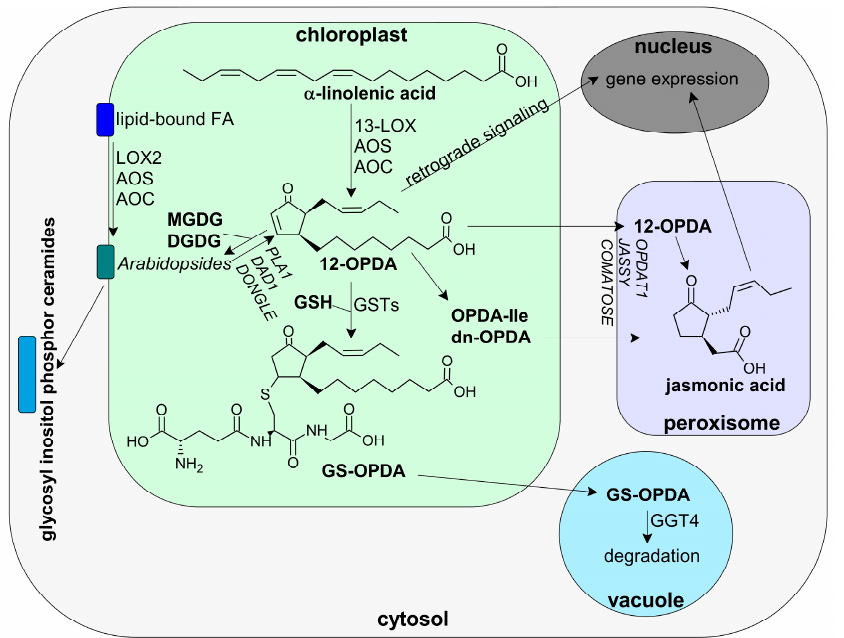
Figure 5. Synthesis and metabolic conversion of 12-OPDA in plant cells. After synthesis from α -LeA by 13-LOX, AOS, and AOC, 12-OPDA can be transported to peroxisomes through the cytosol and converted to JA, which regulates gene expression in a COI-1 dependent matter. Further, 12-OPDA can be stored by binding to MGDG and DGDG, forming Arabidopsides. These storage pools can also be formed directly from lipid-bound fatty acids (FA) by LOX2, AOS, and AOC and might interact with the major sphingolipids GIPC in plant membranes. Further, 12-OPDA forms adducts with GSH which are degraded in vacuoles by γ -glutamyl transpeptidase 4 (GGT4). Without further conversion, 12-OPDA serves as regulator of retrograde signaling.